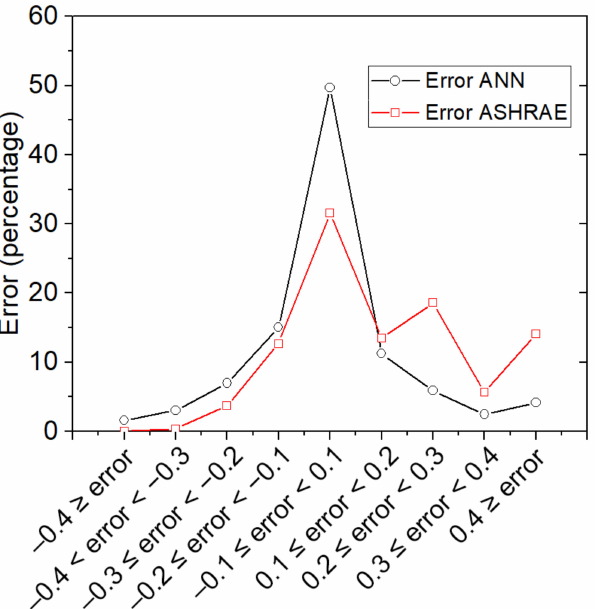
Figure 10. Comparison of the error distribution profile of the developed ANN-based model and the ASHRAE